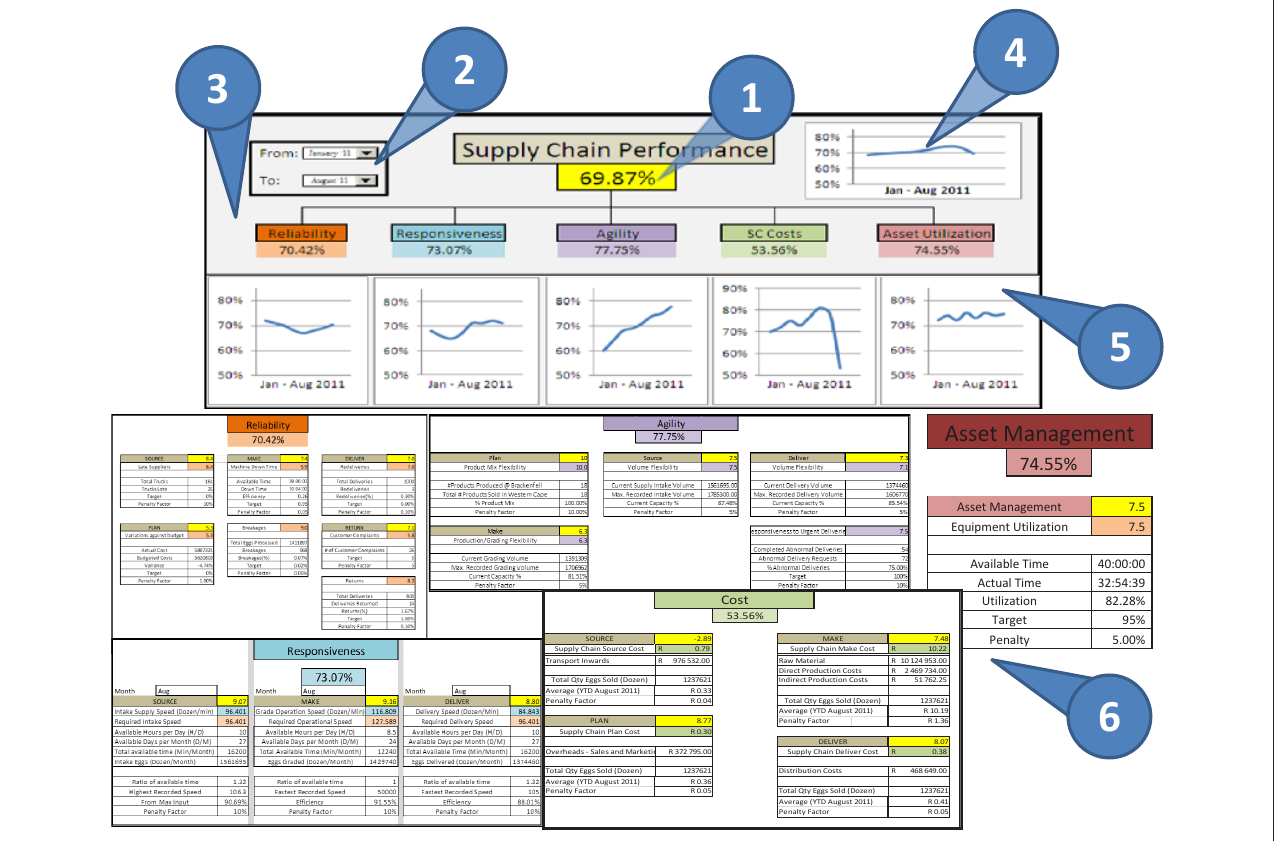
FIGURE 3: Interface layout of the